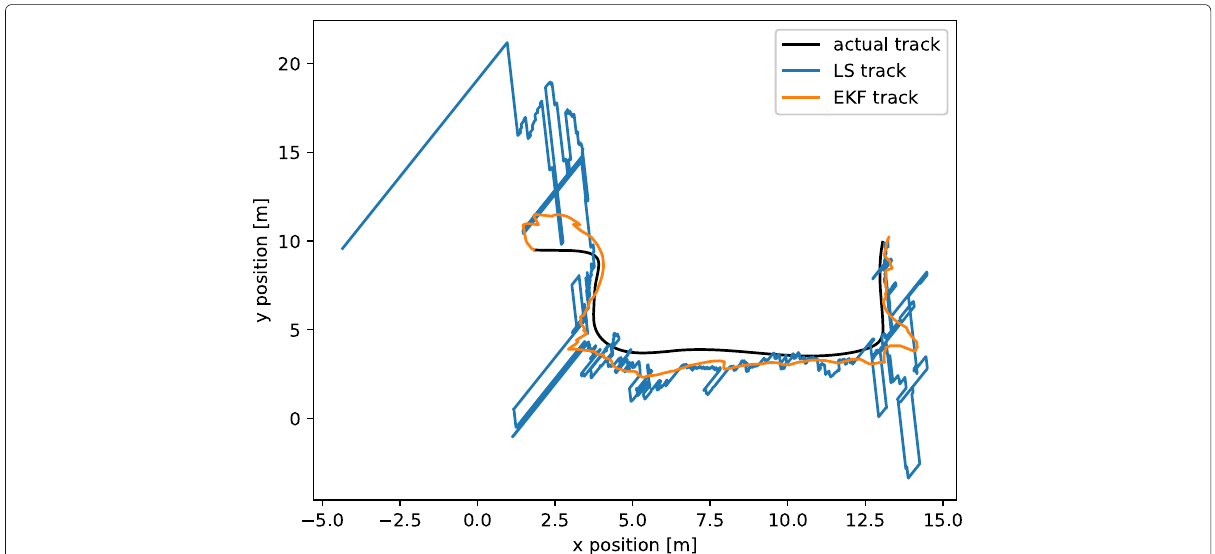
Fig. 6 The performance of LS and EKF tracking algorithms in comparison to the actual (ground truth) walking trajectory